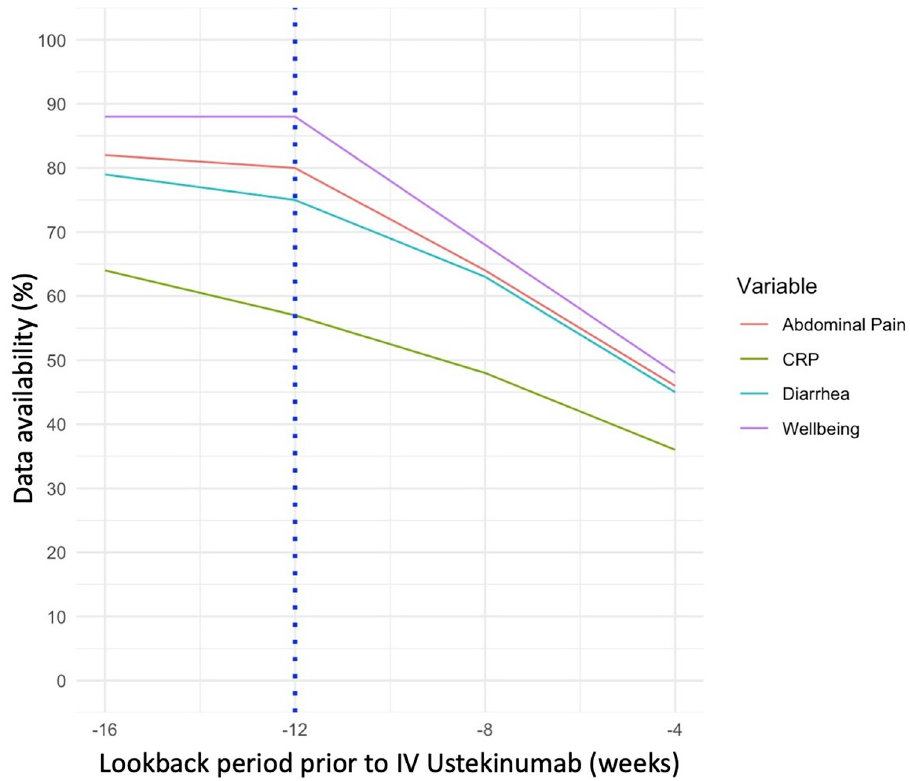
Fig 2. Impact of different definitions for the baseline time period on variable availability. These results correspond to the 183 patients who were not excluded by non-CDAI related study criteria. All of these patient records underwent manual review to ascertain the presence of PROs occurring during the 16 week period prior to the first dose of ustekinumab (week 0). The blue dotted line corresponds to the cut point (12 week lookback) that was selected following a visual review of the trends depicted here. CRP corresponds to c-reactive